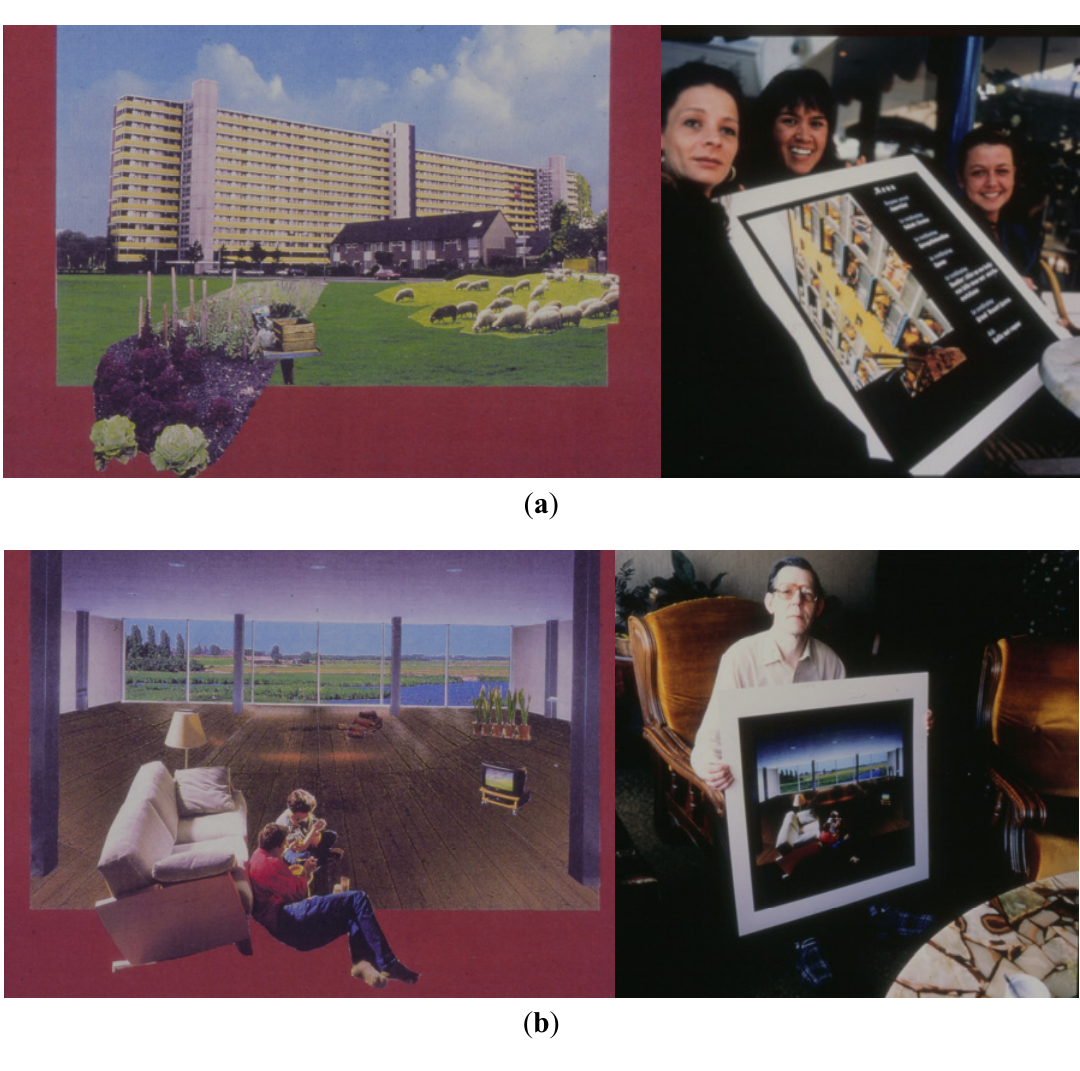
Figure 6. The empty city [103]. ( a ) “The Vertical Restaurant”. Dinner at the highest level. The entrées are served at ground level, coffee with cognac at the rooftop terrace. Every floor has its own course, leading to an evening-long dynamic program. With each course you encounter a new environment with plenty of rooms to choose your preferred dishes. The top is the finale, with its view over the city, splashing water and heated terrace; ( b ) “Out of the Row”. Get three houses for the price of one! When your neighbours have left you could “use” two extra units. One and a half houses become your own and you may use the other one and a half while remaining in the ownership of the housing corporation. You are obliged to maintain the extra units and choose your desired use: a solar plant on the roof, mushrooms in the cellar, vegetables in the greenhouse on the first floor, or a handyman shop at ground level. These are all ways to earn some extra income. From a standard row of eight attached houses, the two middle units could be demolished, leaving two detached houses each the size of three original units. Instead of living in between neighbours you are suddenly surrounded by green